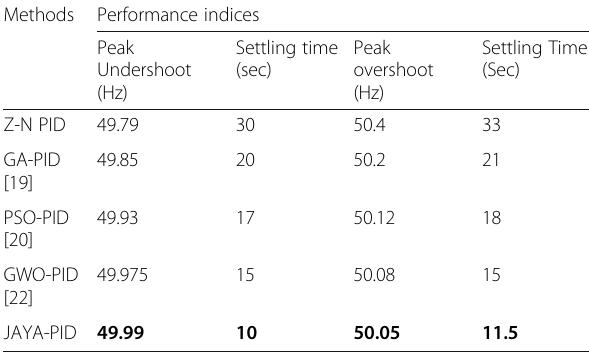
Table 1 Dynamic response of various controllers for scenario 1 Methods Performance indices